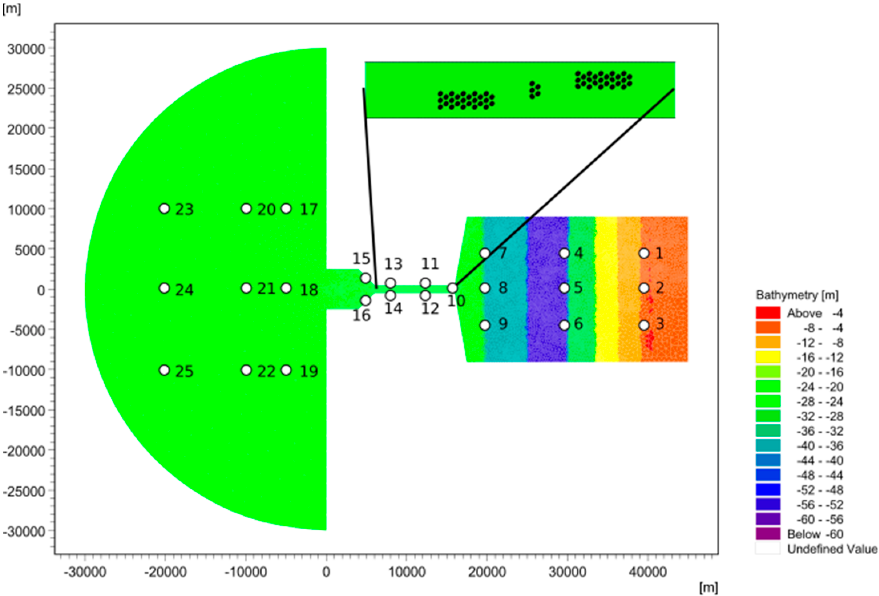
Figure 1. Idealised model of a channel, the outer coastal zone (on the left) and the basin (on the right). The inset displays the setup of the 55 TEDs in the channel. The depth in the channel and outside the channel is constant at 20 m, while the basin has got some deeper areas of up to 60 m and is shoaling out towards the end. Concentrations of the state variables were recorded at the displayed 25 points, 1–9 in the basin, 10–16 in the channel, and 17–25 outside the channel.